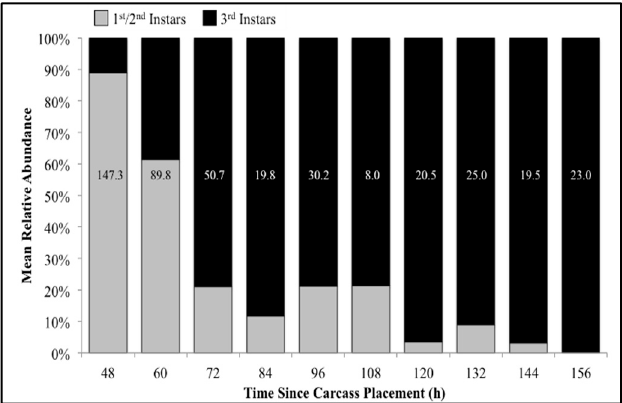
Figure 5. Mean relative abundance of first/second (pooled) and third instars of all species collected throughout decomposition. Numbers on each column represent the average number of larvae (all instars) collected at that time point.